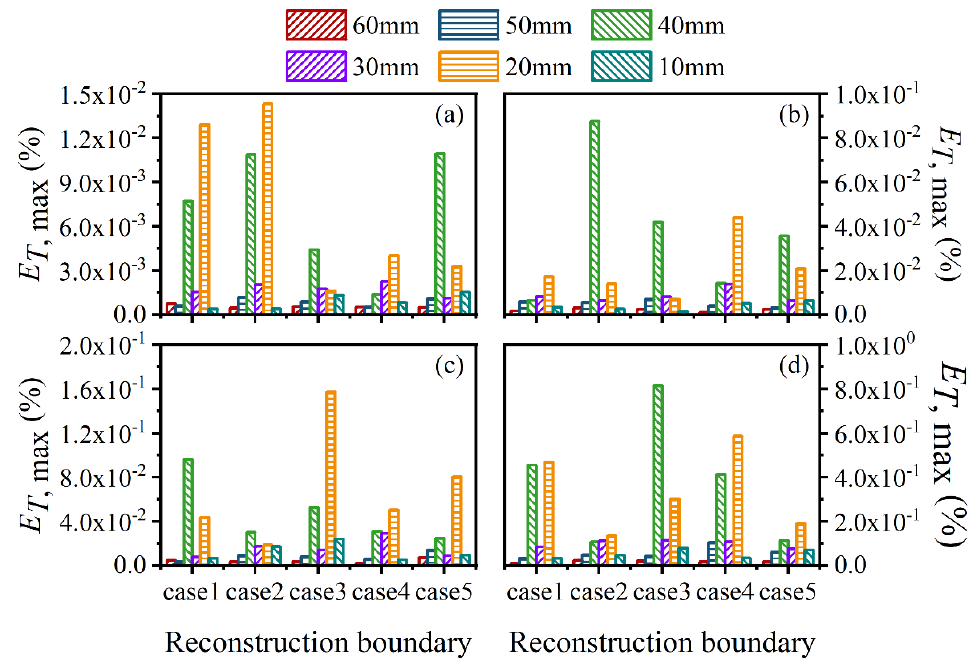
Figure 23. The maximum relative reconstruction error for temperature with different SNR considering different reconstruction boundaries. ( a ) SNR = 80 dB; ( b ) SNR = 65 dB; ( c ) SNR = 60 dB; ( d ) SNR = 46 dB.